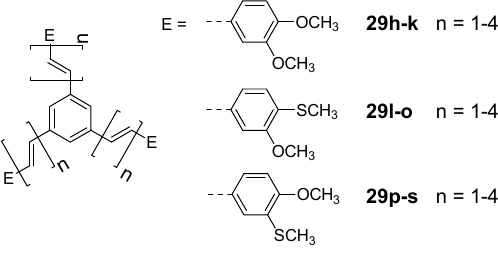
Figure 16. 1,3,5-Tris(oligoethenyl)benzene derivatives showing nonlinear optical response. E